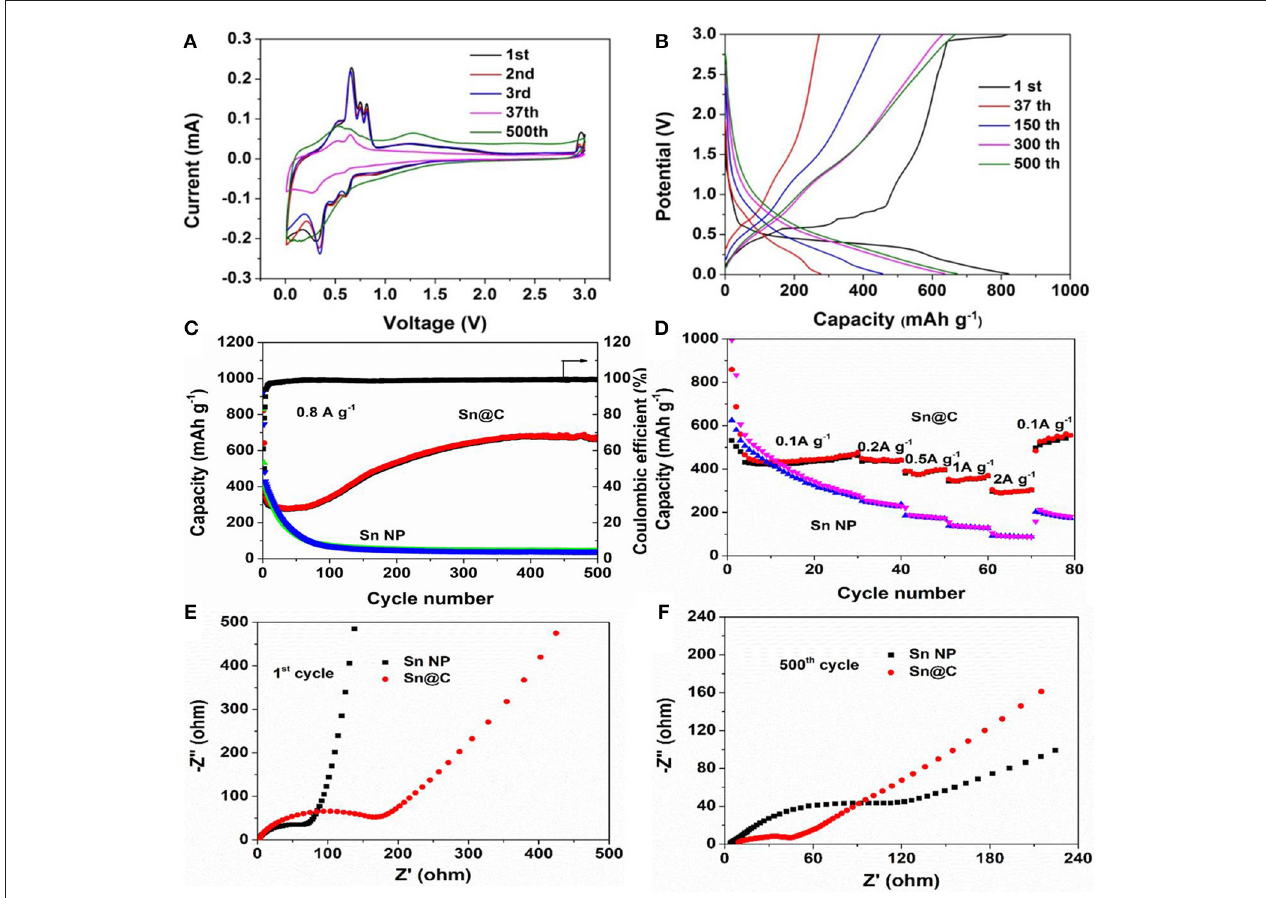
FIGURE 4 | (A) CV curves of Sn@C at a scanning rate of 0.1mV s − 1 between 0.1 and 3V, (B) charge-discharge curves of Sn@C at 0.8A g − 1 , (c) cycling performance of Sn@C and Sn NPs at 0.8A g − 1 , (D) rate capacity of Sn@C and Sn NPs, (E) Nyquist plots of samples before cycle, (F) Nyquist plots of samples after 500 cycles.